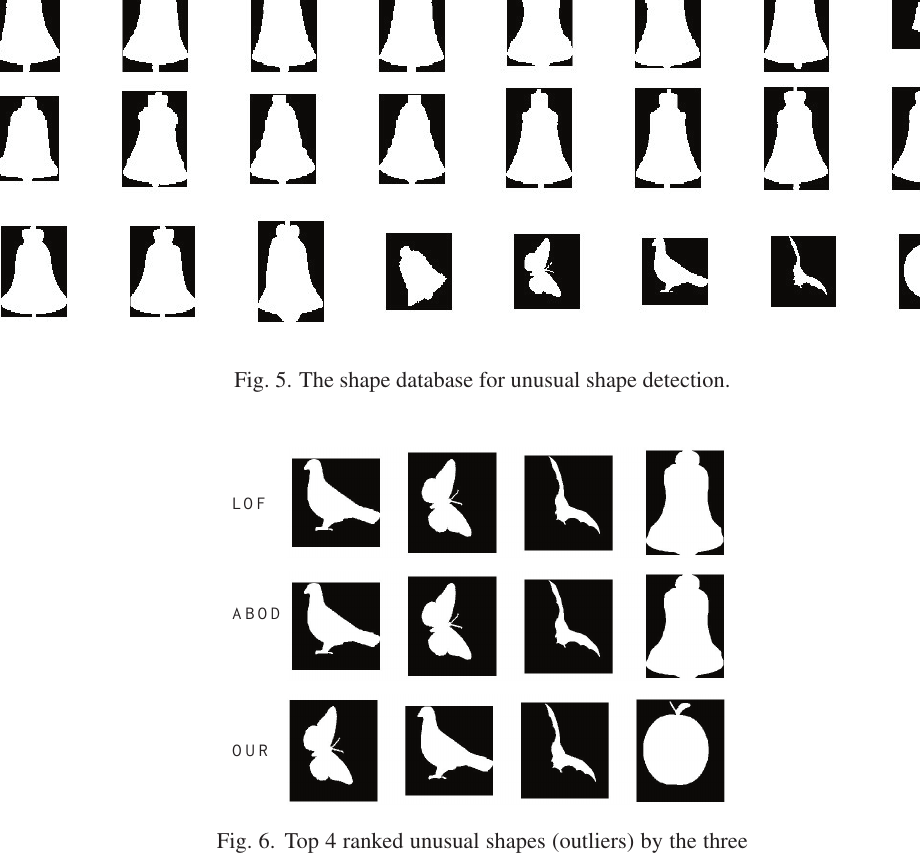
Fig. 6. Top 4 ranked unusual shapes (outliers) by the three